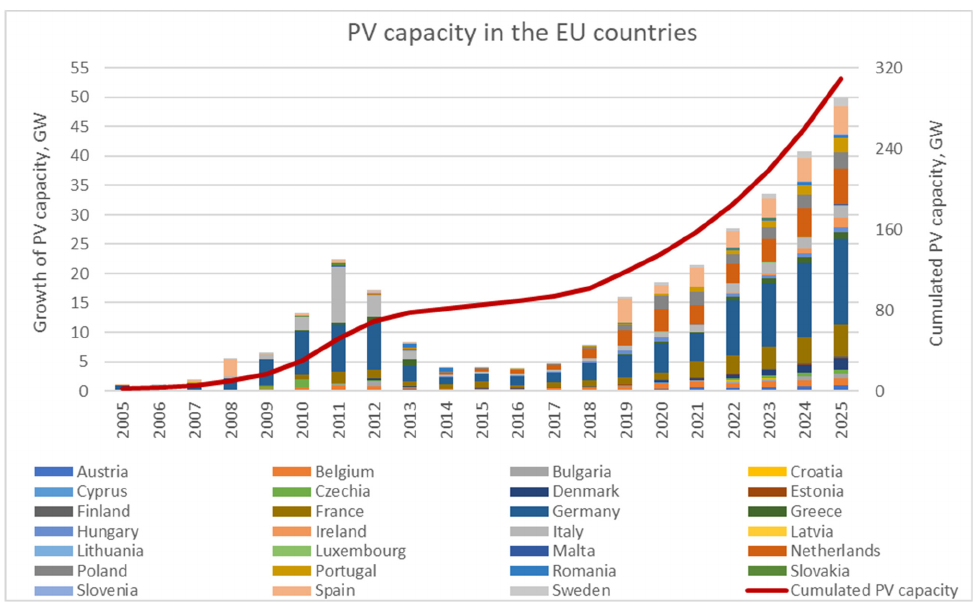
Figure 4. PV capacity—cumulated and annual increase—in the EU.